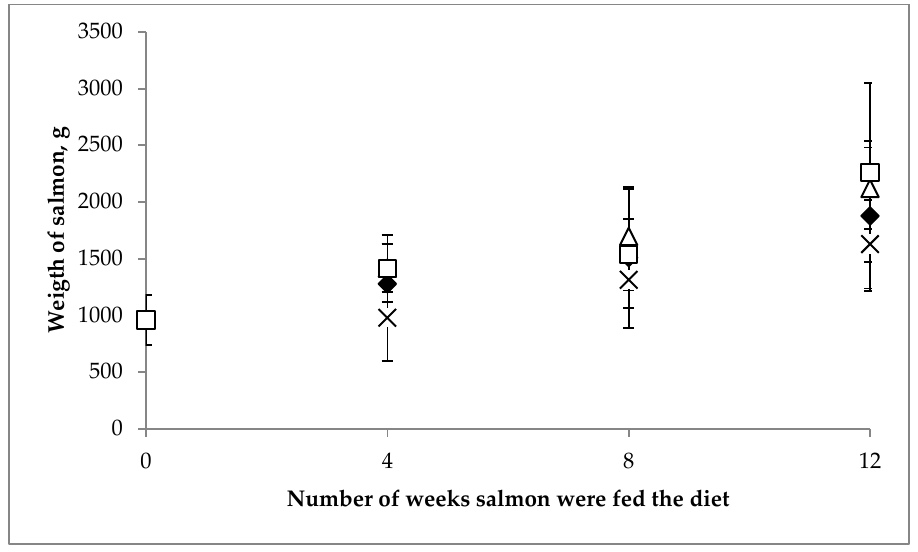
Figure 2. Growth performance shown as weight (x ± SD) in grams for farmed Salmo salar ( n = 10) at baseline, week 4, 8 and 12, in the four feeding groups receiving vitamin D at the dietary level of 270 µg/kg ( ♦ ), 590 µg/kg (x), 890 μg/kg (Δ) and 1440 μg/kg (□).